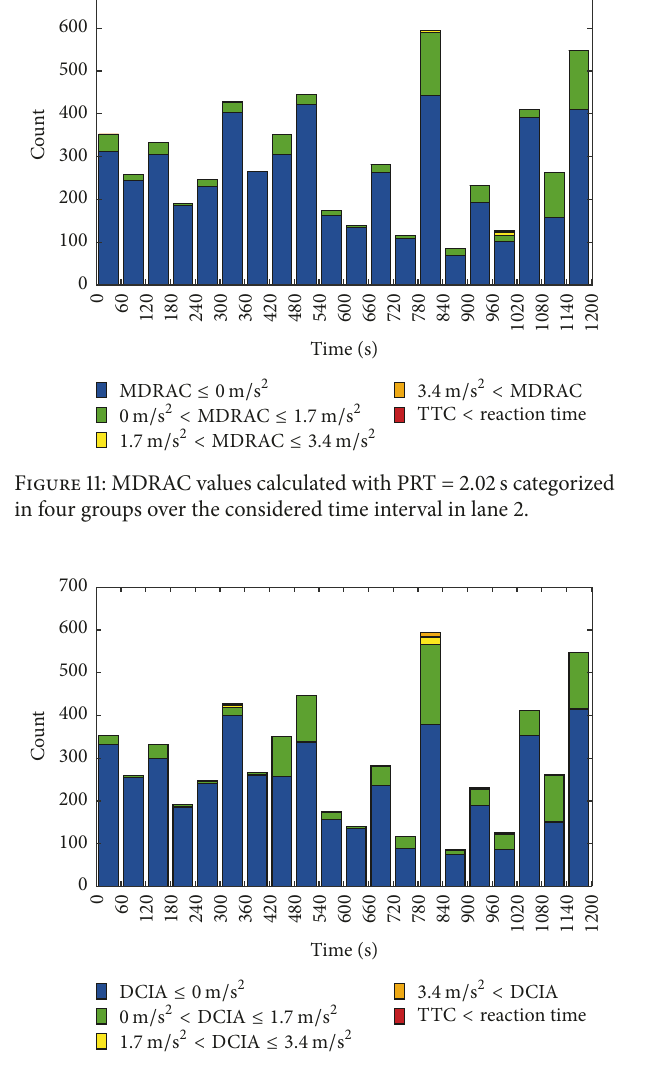
Figure 12: DCIA values calculated with PRT = 1.3 s categorized in four groups over the considered time interval in lane 2.